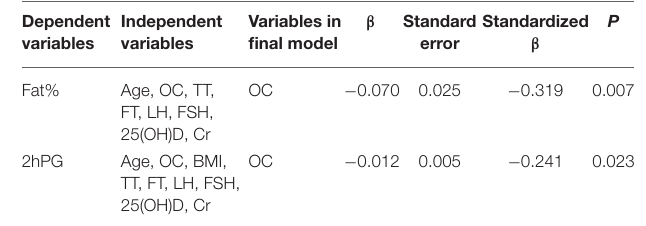
TABLE 2 | Factors determining the variation of GRI in multivariate stepwise regression analysis.